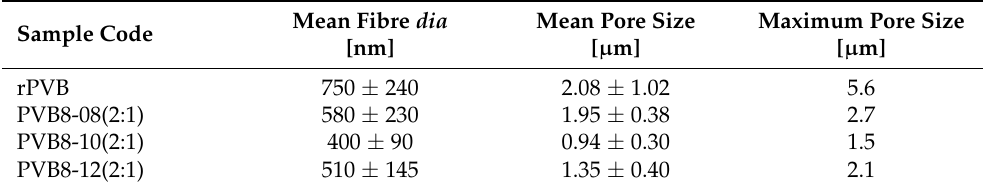
Table 8. Basic morphological characteristics of chosen nanofibrous webs.